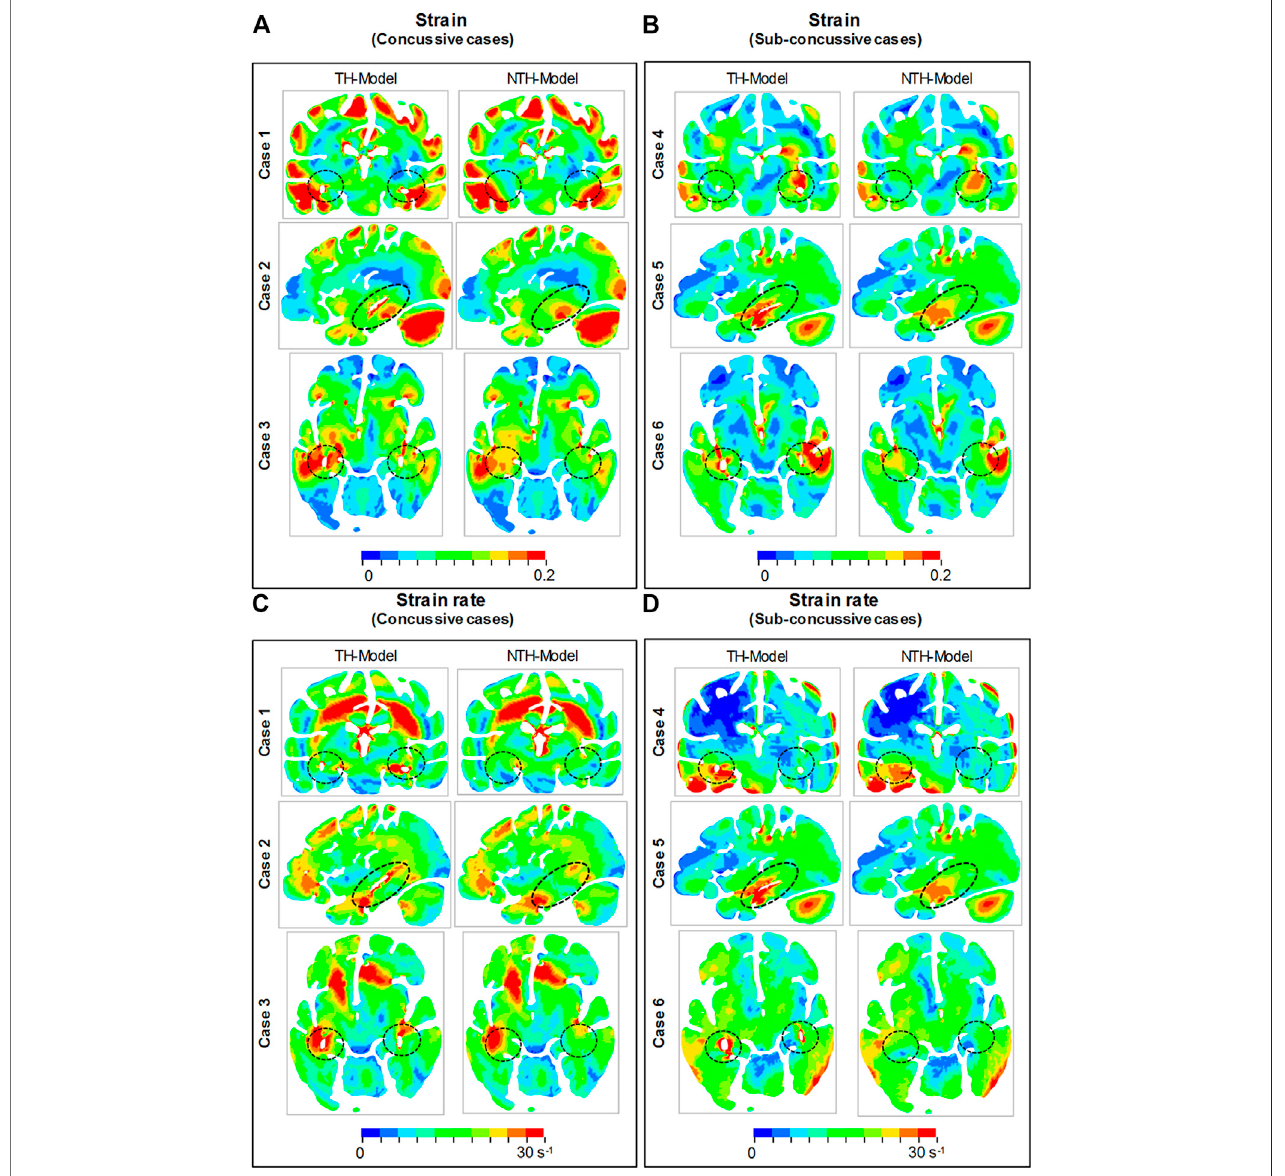
FIGURE 3 | Comparison of the maximum principal strain (A,B) and strain rate (C,D) distribution between the TH-model and NTH-model for three concussive and three sub-concussive impacts (Cases 1 – 3 and 4 – 6 respectively). The temporal horn and adjacent tissue are highlighted by black dashed ellipses.